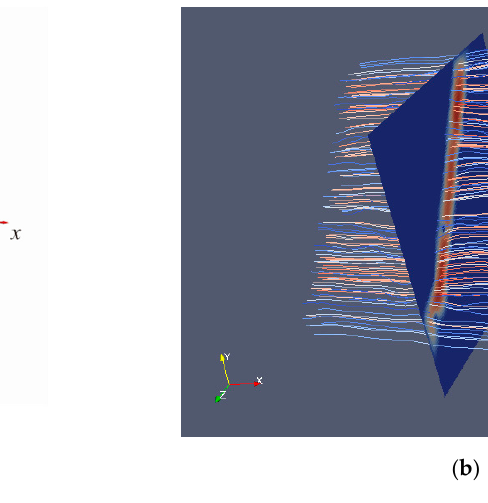
( b ) Figure 13. The relationship between permeability and confining pressure: ( a ) the first cycle, ( b ) the second cycle. The following result can be obtained from Figure 13: the variation of permeability with cyclic stress is similar to that of fracture aperture with cyclic stress. In other words, under low effective stress, the fracture permeability decreases faster, and the influence of the first cycle on the core permeability is more severe. In Figure 13a, when the confining pressure is reduced to 0 MPa, the dimensionless permeability is only 0.333, which is 94.6% lower than that of 6.112 at the initial time (0 MPa) of the loading stage. This result indicates that coal sample 2–5 is strongly sensitive to stress in the first cycle. In the second cycle, it is found that the permeability decreases by 50.8% at 0 MPa, which means that the stress sensitivity is weaker than that of the first cycle. By placing the results of two cycles in the same graph, as shown in Figure 14, we can conclude that after the first cycle loading, the permeability will always be maintained at a low level, that is, the permeability of fractures is more sensitive to the effective stress of the first cycle. In addition, in the loading stage of the first cycle, the permeability is close to 0 when the pressure reaches 5 MPa, that is, the fracture closure area greatly reduces the fracture permeability. In the second cycle, when the pressure reaches 3 MPa, the fracture permeability is already close to 0.